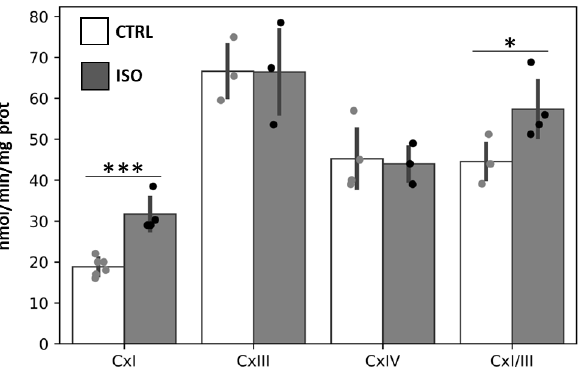
Figure 1. Effect of isoproterenol treatment on activity of mitochondrial respiratory chain complexes. The H9c2 cell cultures were incubated for 30 min in absence (CTRL) or in the presence of 1 µM isoproterenol (ISO). The activities of complexes I (CxI), III (CxIII), IV (CxIV) and I + III (CxI/III) were measured spectrophotometrically. The scatter bar graphs represent the means ± standard deviation (SD). CTRL vs. ISO, * p < 0.05, *** p < 0.001, Student’s t -test.